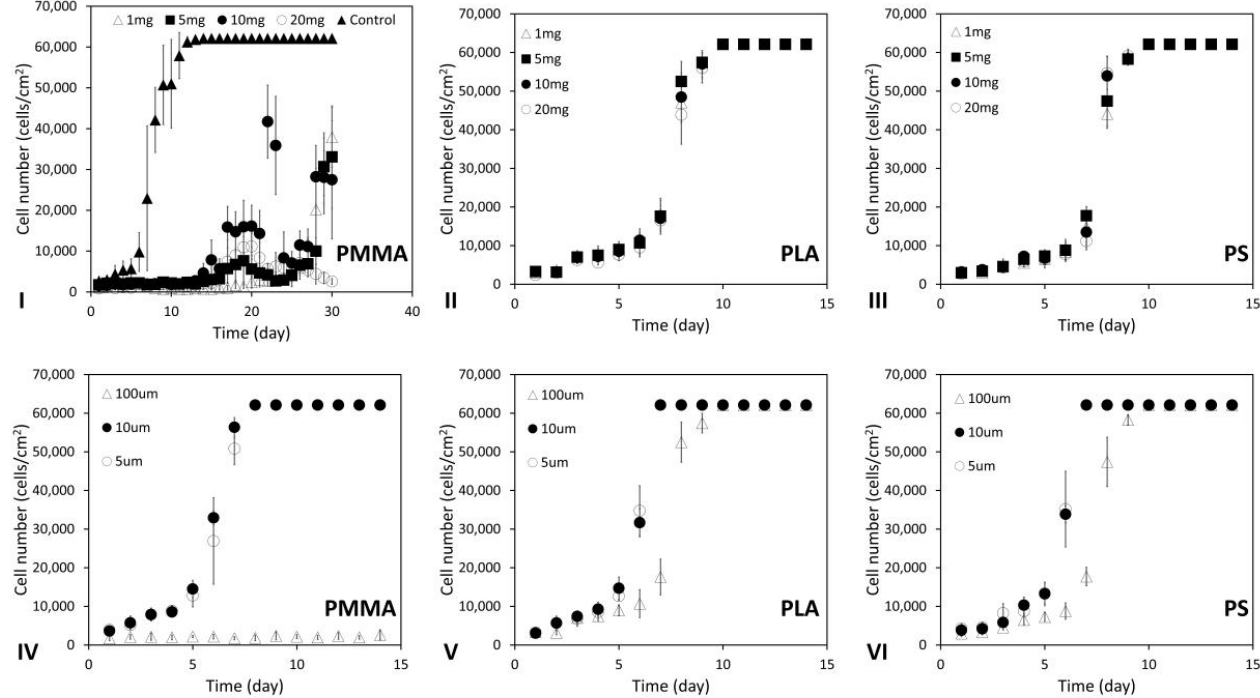
Figure 3. ( I – III ) The influences of particle material and number on the neighboring 2D cell cultures. Aliquots of 1 mL of HDFs (10 5 cells/mL) were seeded into each of T25 flasks containing 1, 5, 10 or 20 mg of ( I ) PMMA, ( II ) PLA or ( III ) PS particles with defined diameter (100 µ m) in 5 mL DMEM media and cultured for 14–30 days. ( IV – VI ) The influences of particle material and size on the neighboring 2D cell cultures. The same procedure was used to culture HDFs in each of T25 flasks containing 5 mg of ( IV ) PMMA, ( V ) PLA or ( VI ) PS particles with different diameters (5–100 µ m) for 14 days. The cells on the flat surfaces of T25 flasks were estimated on daily basis via PCM. In all these experiments, T25 flasks containing no polymeric particles were used as the controls. Results shown are mean ± standard deviation (SD) ( n = 3 independent